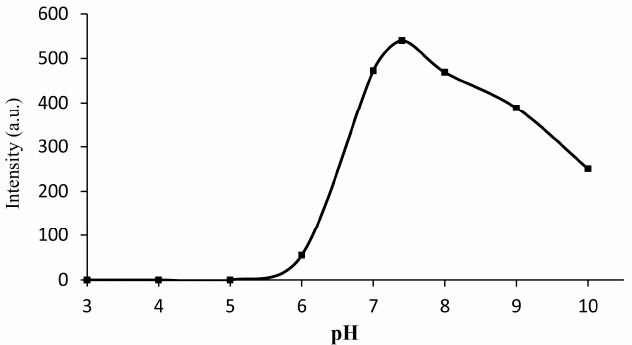
Figure 4. The effect of pH on the fluorescence response of the probe (10 μ M) in the presence of Cys (500 μ M) in buffered solution (PBS:DMSO = 6:4, pH = 3–10), pH was adjusted by NaOH and HCl. λ ex = 325 nm, λ em = 450 nm.